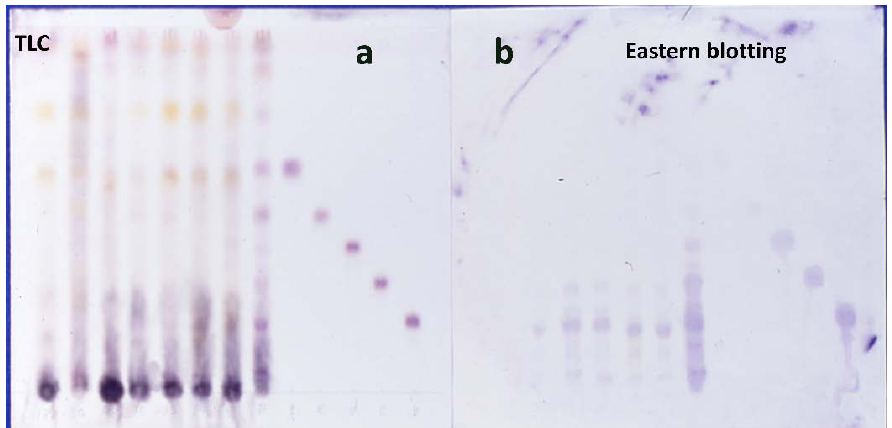
Figure 2. Eastern blotting of ginsenosides in traditional Chinese medicine formulas using anti-ginsenoside Rb1 MAb.